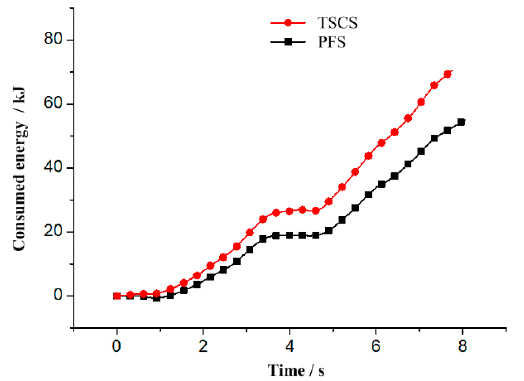
Figure 17. Consumed energy curves of the two systems.